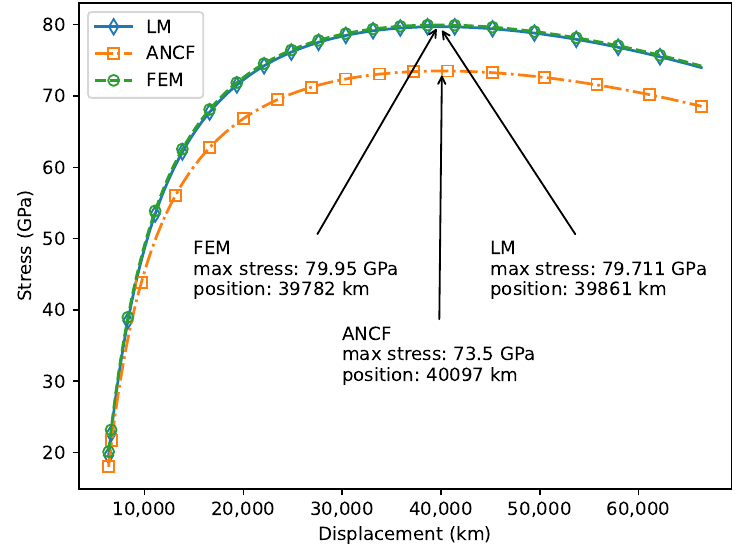
Figure 6. Stress results of three method.